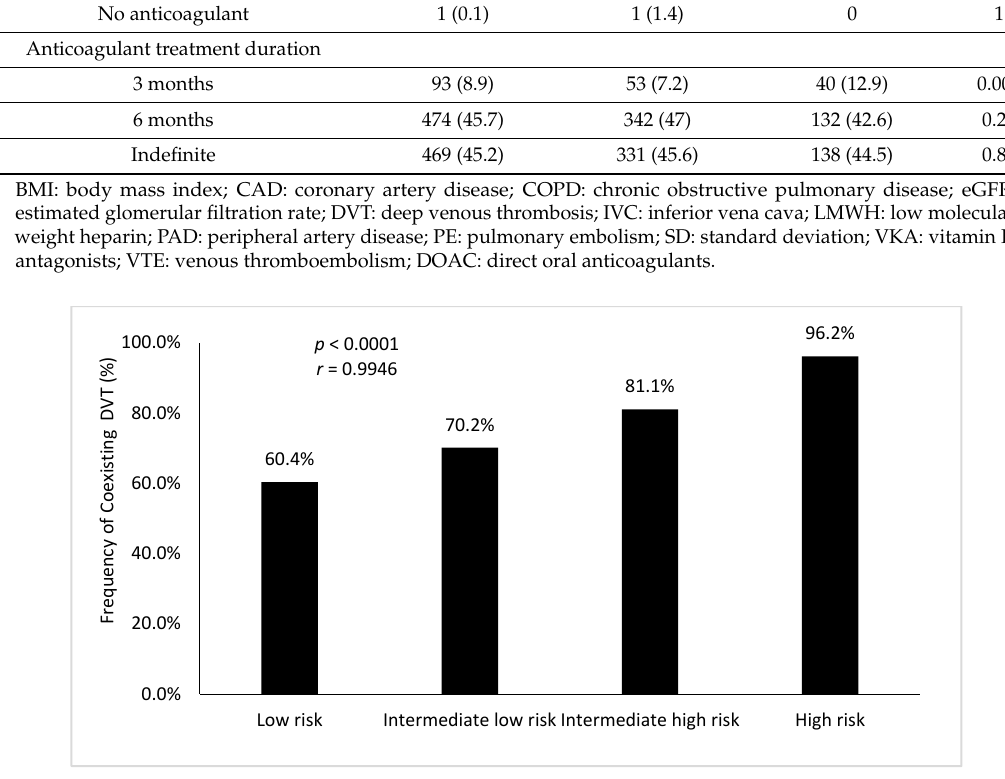
Figure 2. Presence of coexisting deep vein thrombosis (%) according to pulmonary embolism severity. DVT: deep vein thrombosis. r : Pearson’s correlation coefficient. Table 2. Univariate and multivariate analysis of baseline risk factors for pulmonary embolism severity.